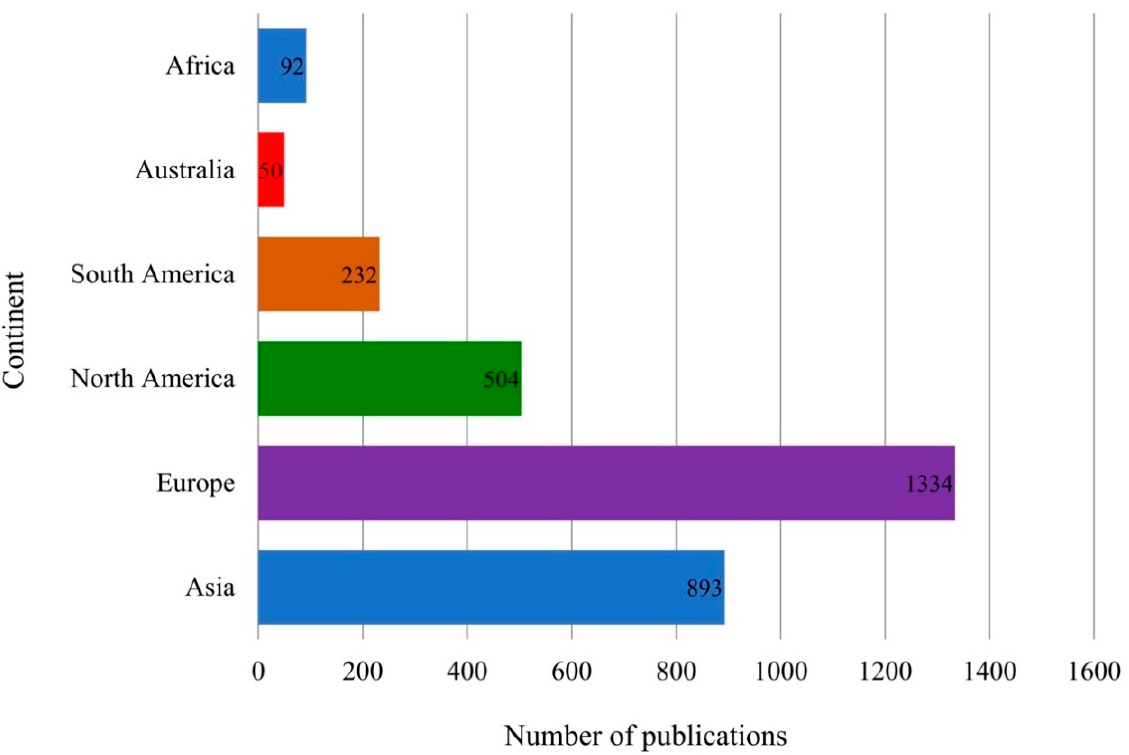
Figure 1. Research trend of microbial exopolysaccharides published in Scopus based on conti- nents.